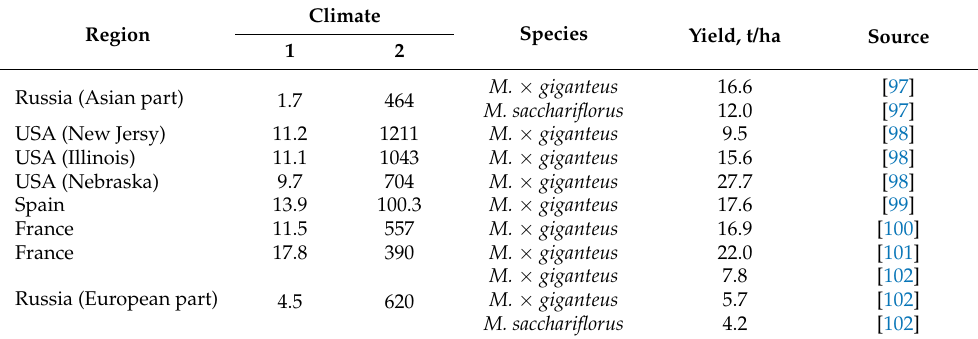
Table 4. Miscanthus yield in different regions of the